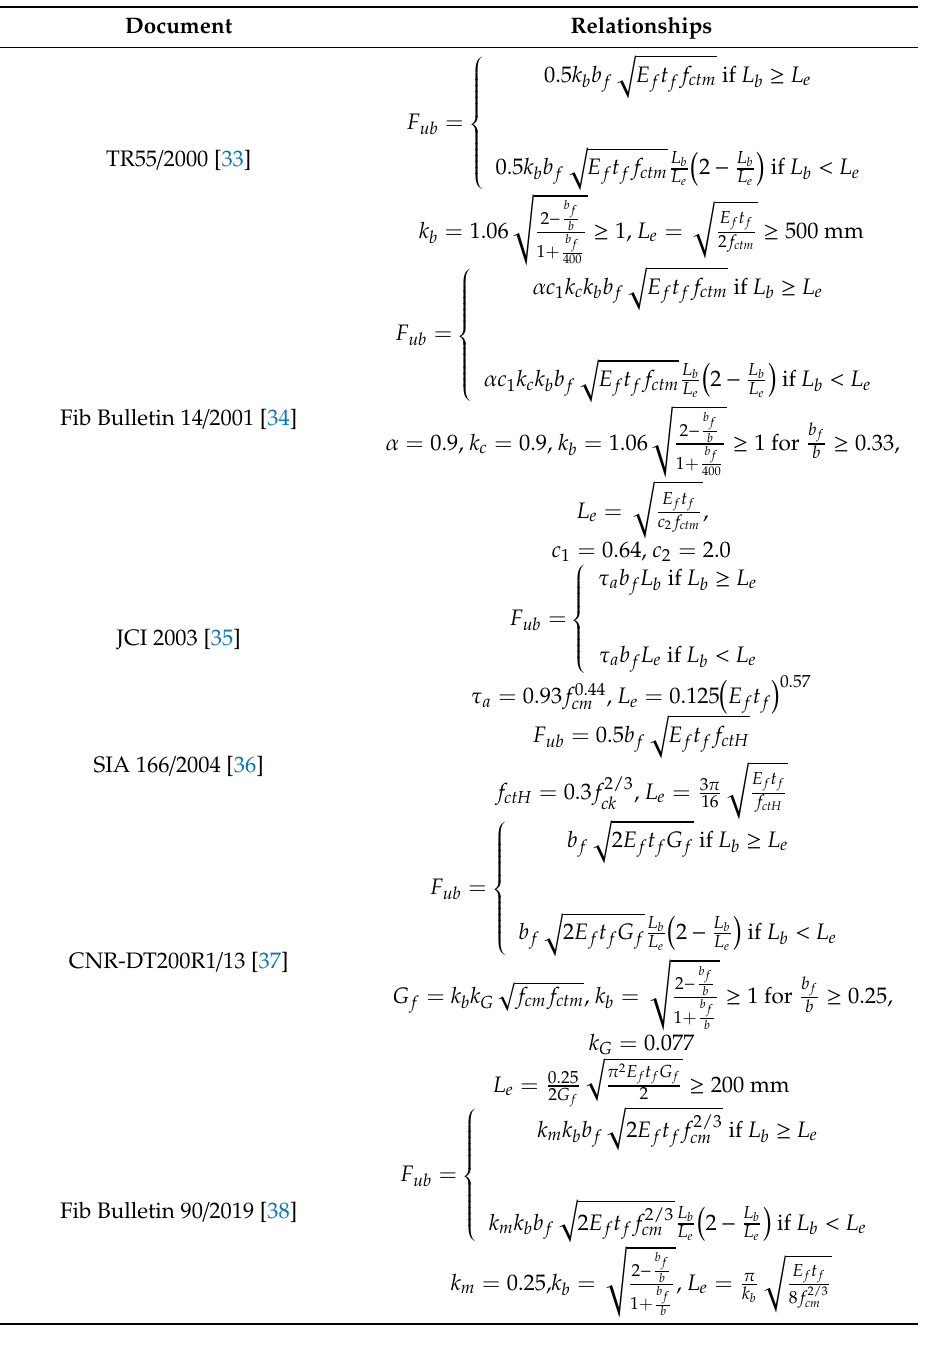
Table 2. Relationships for the FRP-concrete bond proposed in the selected technical guidelines (without safety